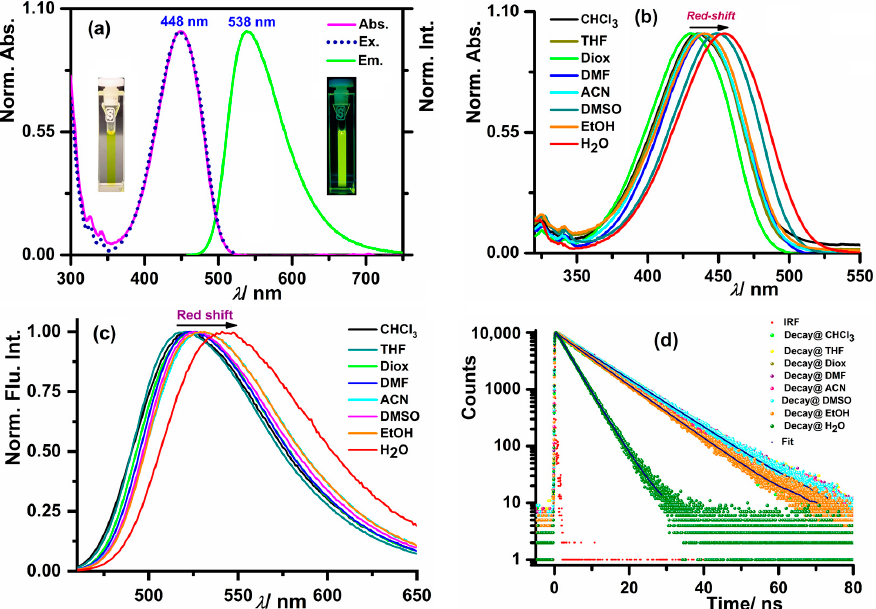
Figure 1. ( a ) Absorption, emission, and excitation spectra of the probe in DMSO, superimposition of absorption and excitation spectra representing the optical purity, inset shows cuvette images un- der daylight and UV light illumination; solvent-dependent ( b ) absorption and ( c ) emission spectra of the probe (10 µM) ( d ) time-resolved fluorescence decay of the probe measured in different sol- vents.